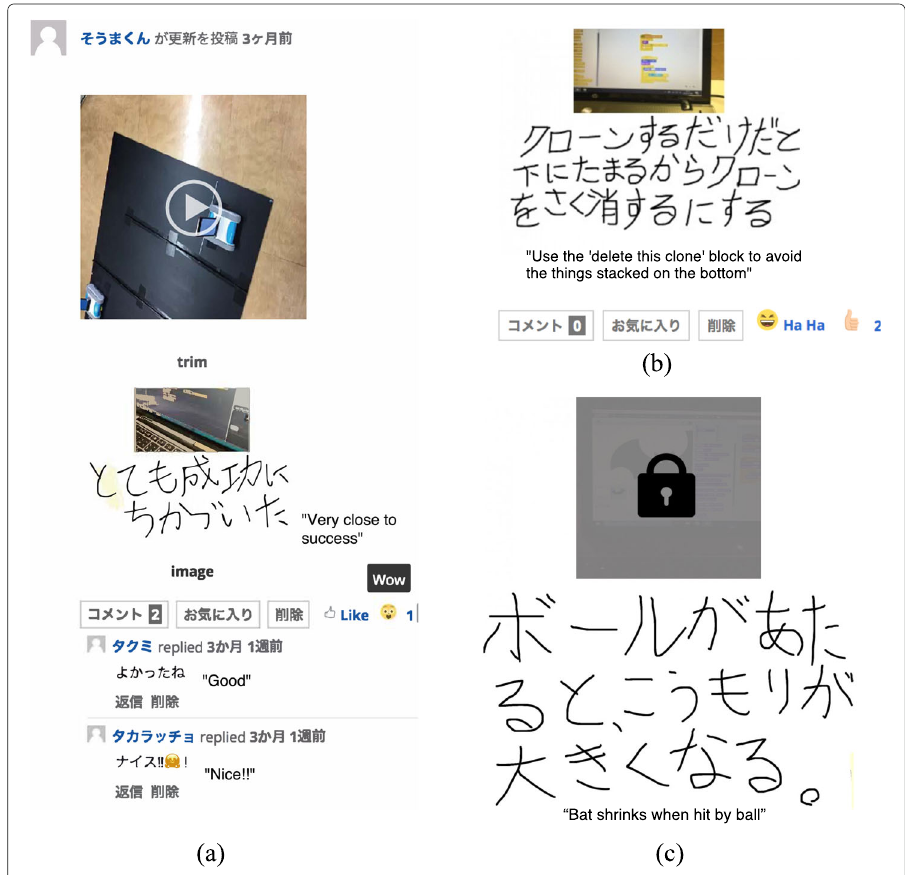
Fig. 10 Examples of posts a for self-reflection and b for knowledge sharing c with program screen hidden